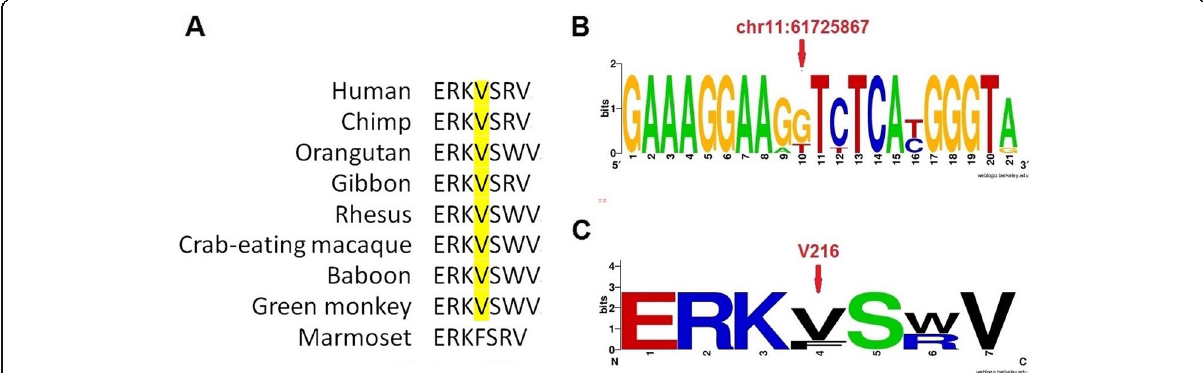
Fig. 3 Conservation analysis using the UCSC Genome Browser database. a Schematic representation of amino acid sequence alignment around the p.V216I variant in different species. b DNA WebLogo of the variant regions. c A conservational logo of amino acids of BEST1 protein position 216 (Valine) generated by WebLogo online